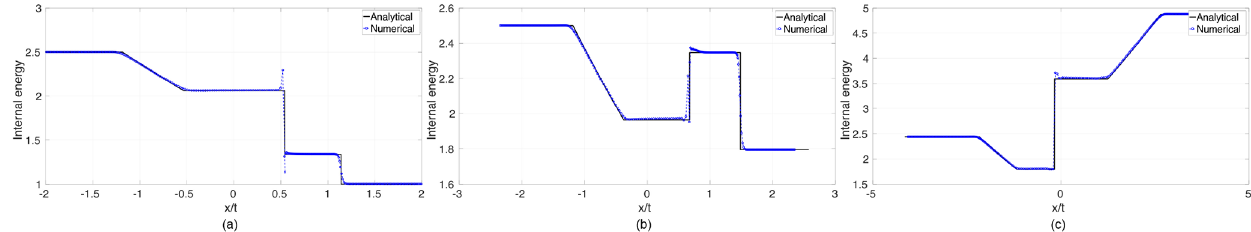
Figure 6. Comparison of specific internal energy of simulation results against analytical results for shock tube tests. The plots from left to right correspond to test 1, test 2 and test 3, respectively.